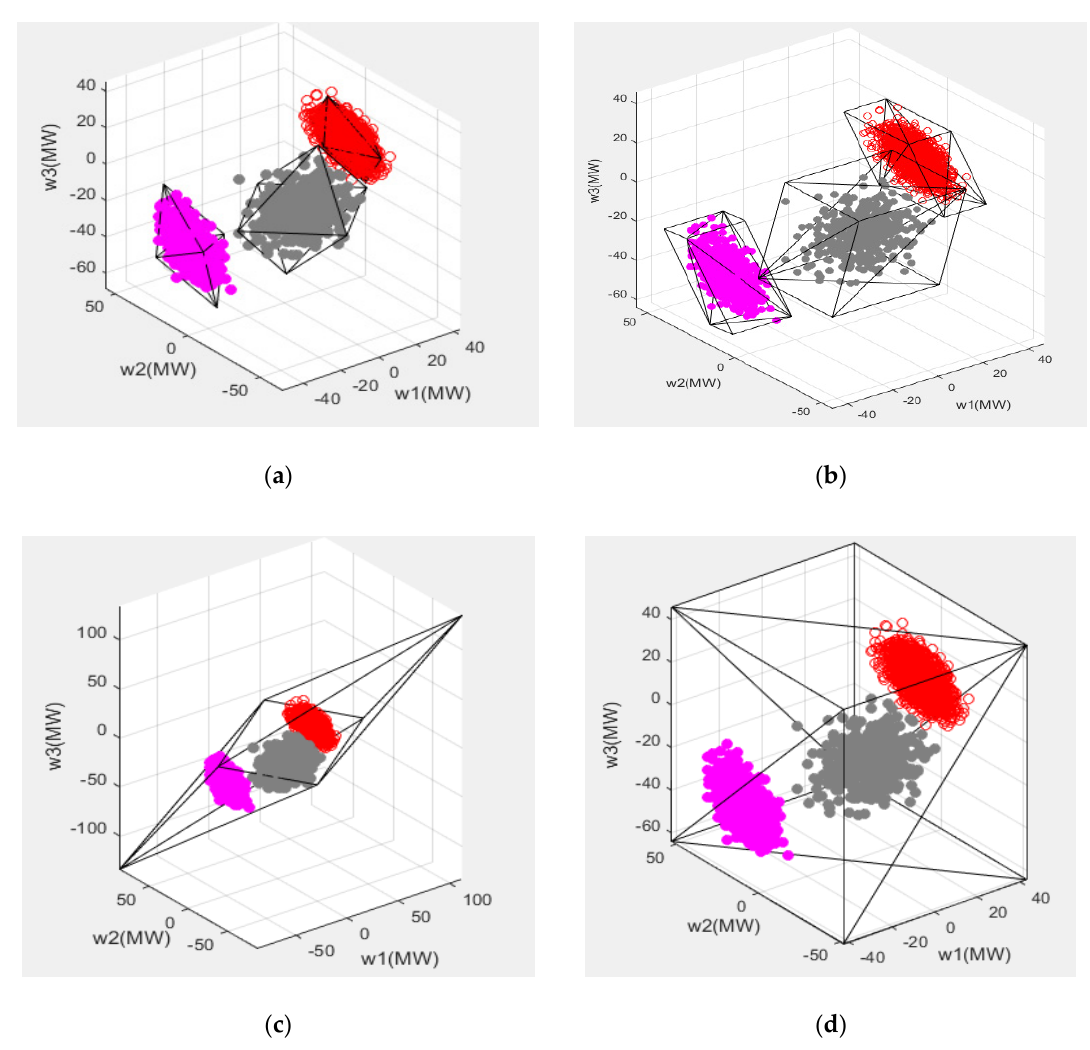
Figure 8. ( a ) Data driven polyhedral uncertainty set W D ∞ ; ( c ) Polyhedral uncertainty set P 1